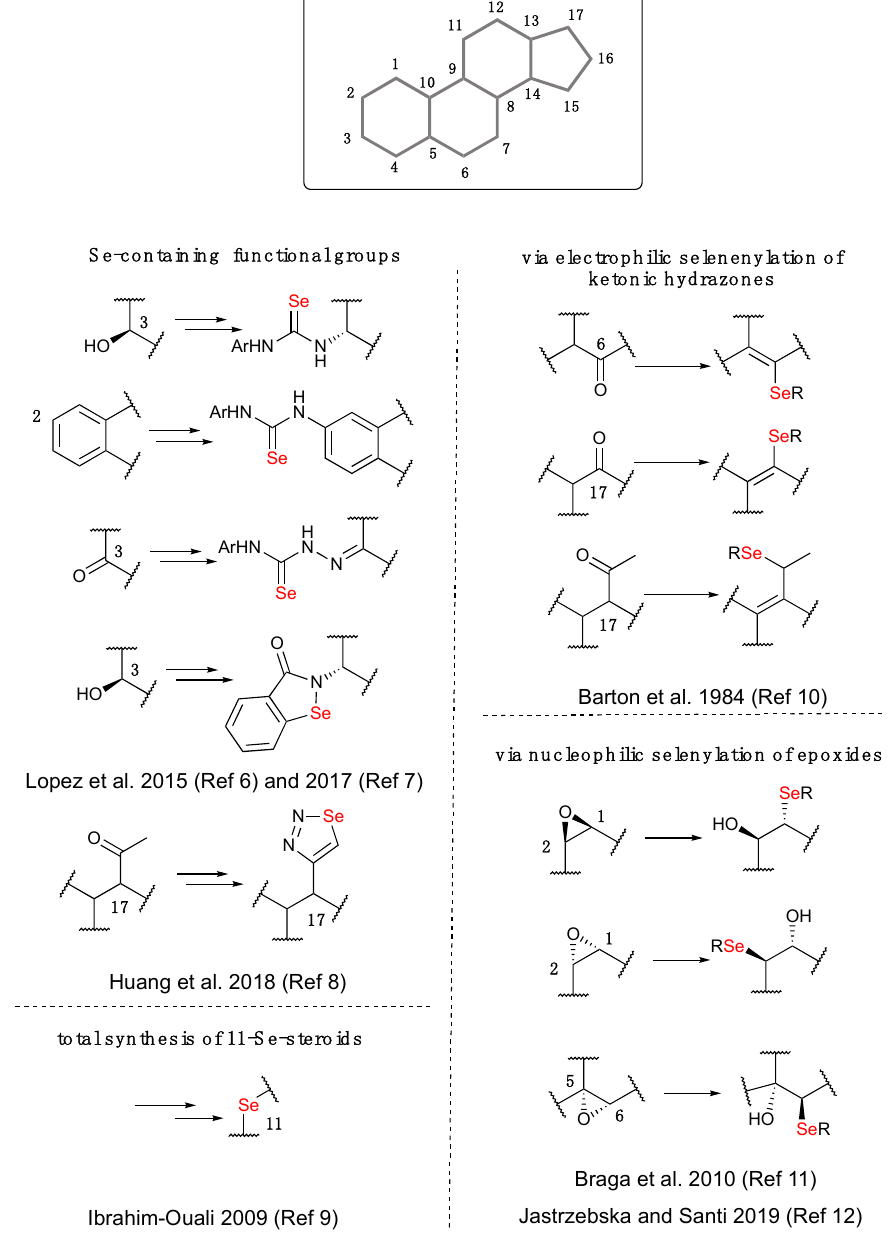
Figure 1. Examples of Se-functionalization on cyclopentanoperhydro-phenanthrene skeleton.